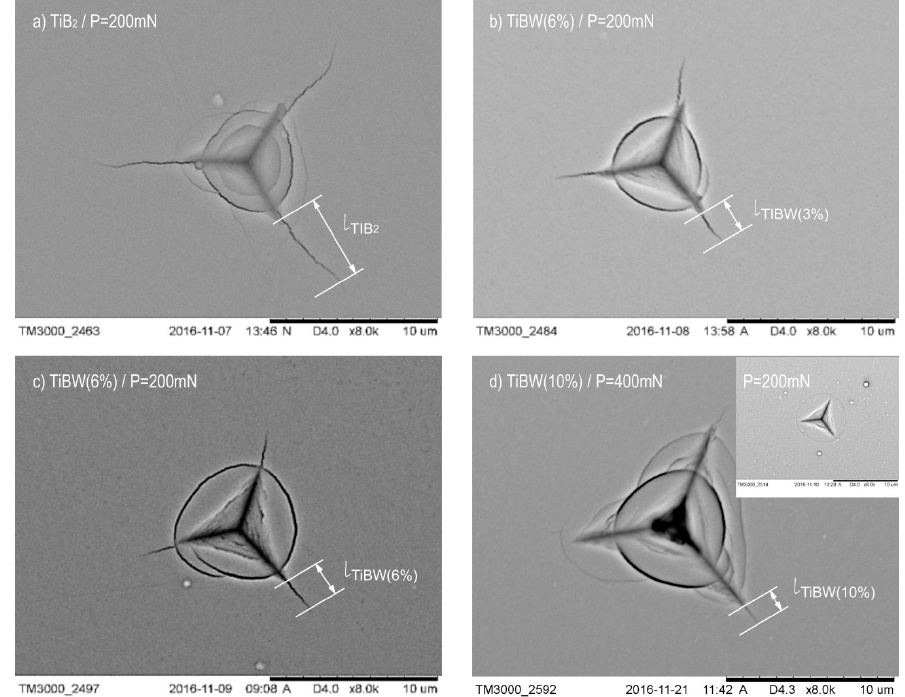
Figure 4. The indentations for selected TiB 2 and Ti-B-W coatings after testing with different values of indenter loading force: ( a ) TiB 2 : 200 Mn; ( b ) Ti-B-W (3%): 200 mN; ( c ) Ti-B-W (6%): 200 mN; ( d ) Ti-B-W (10%): 400 mN.